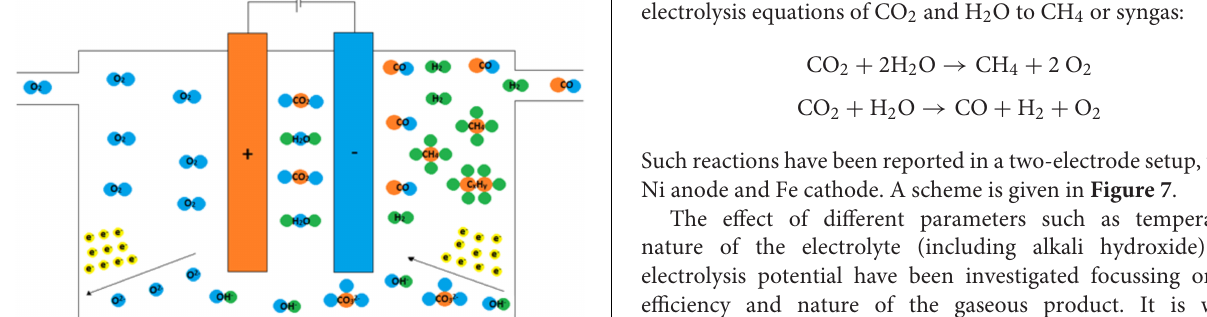
carbonates as a monovalent hydrogen source in CO 2 capture and